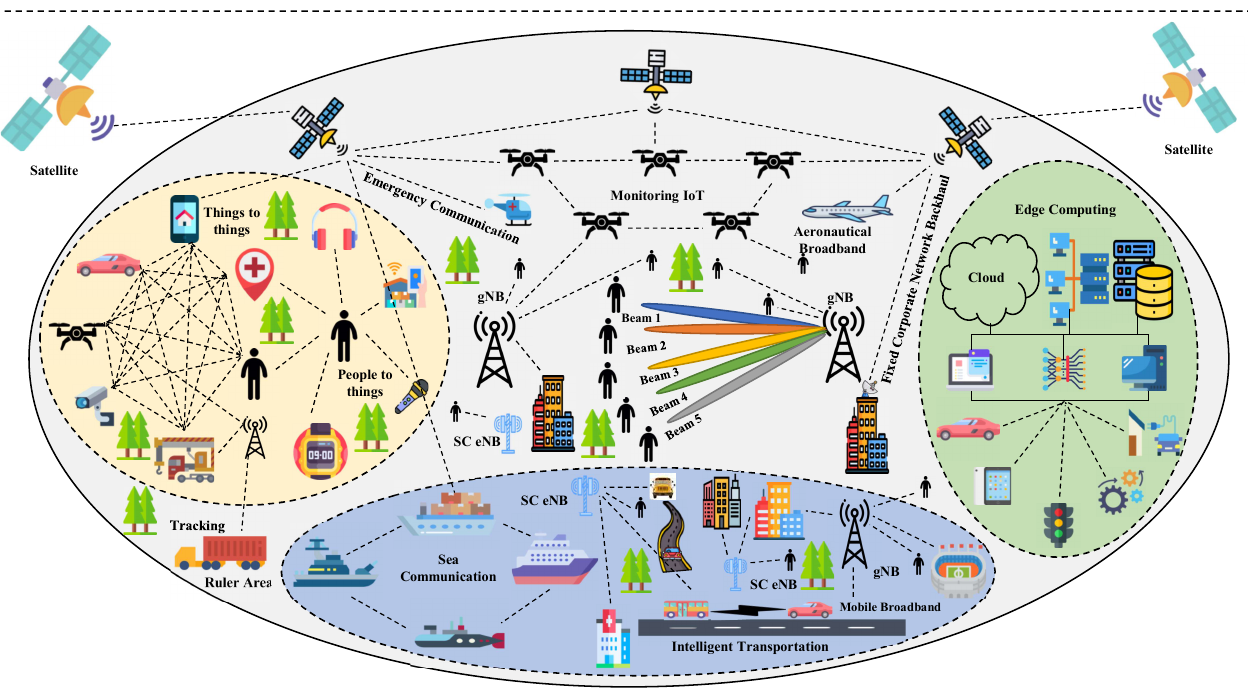
Figure 1. 5G network